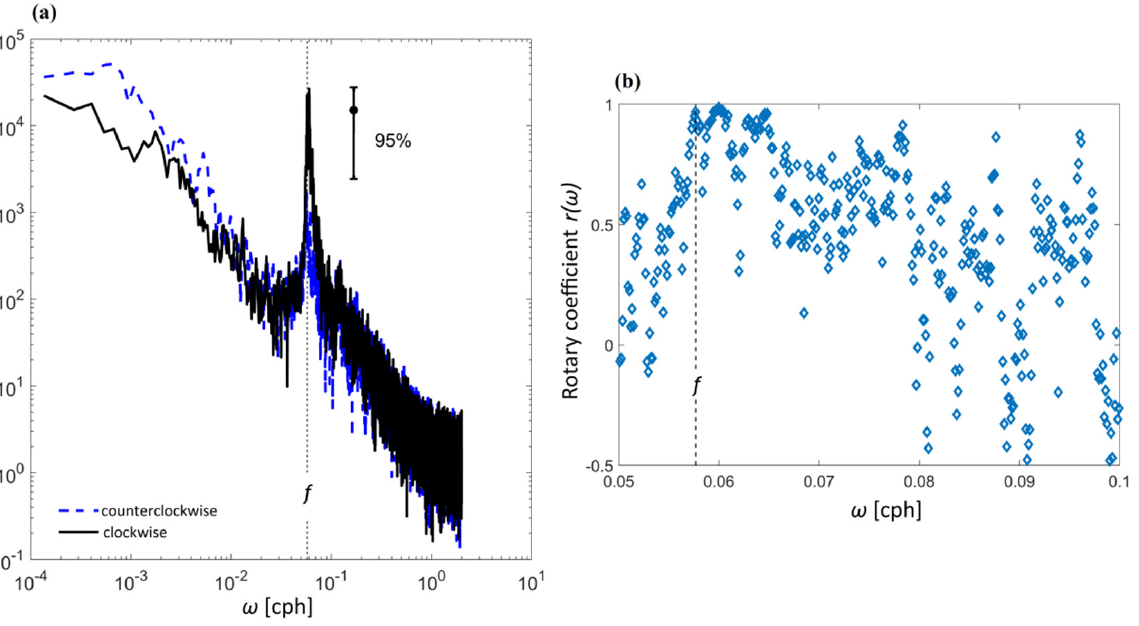
Figure 5. ( a ) Rotary spectra of the clockwise and counterclockwise current vector rotation motions at 100 m at ABS No. 1. In the left plot, the vertical dotted line indicates the local inertial frequency 𝑓 at the mooring site. ( b ) Rotary coefficient in the range of near-inertial frequencies. The clockwise power spectra of the current velocity at 100 m for each month are shown in Figure 6. A distinct peak was found at a frequency of 0.058–0.061 cph (in the range of periods 17.24–16.39 h) every month. At 100 m depth, the energy peak was highest in February and lowest in July (inset in Figure 6). The ratio of the peaks in Feb- ruary and in July was about 8.5. In the deep layer at 1700 m, there was also a significant peak near the inertial fre- quency (Figure 7), and the anticyclonic velocity component prevailed over the cyclonic. The NIWs were most energetic in January and weakest in June. The ratio between the